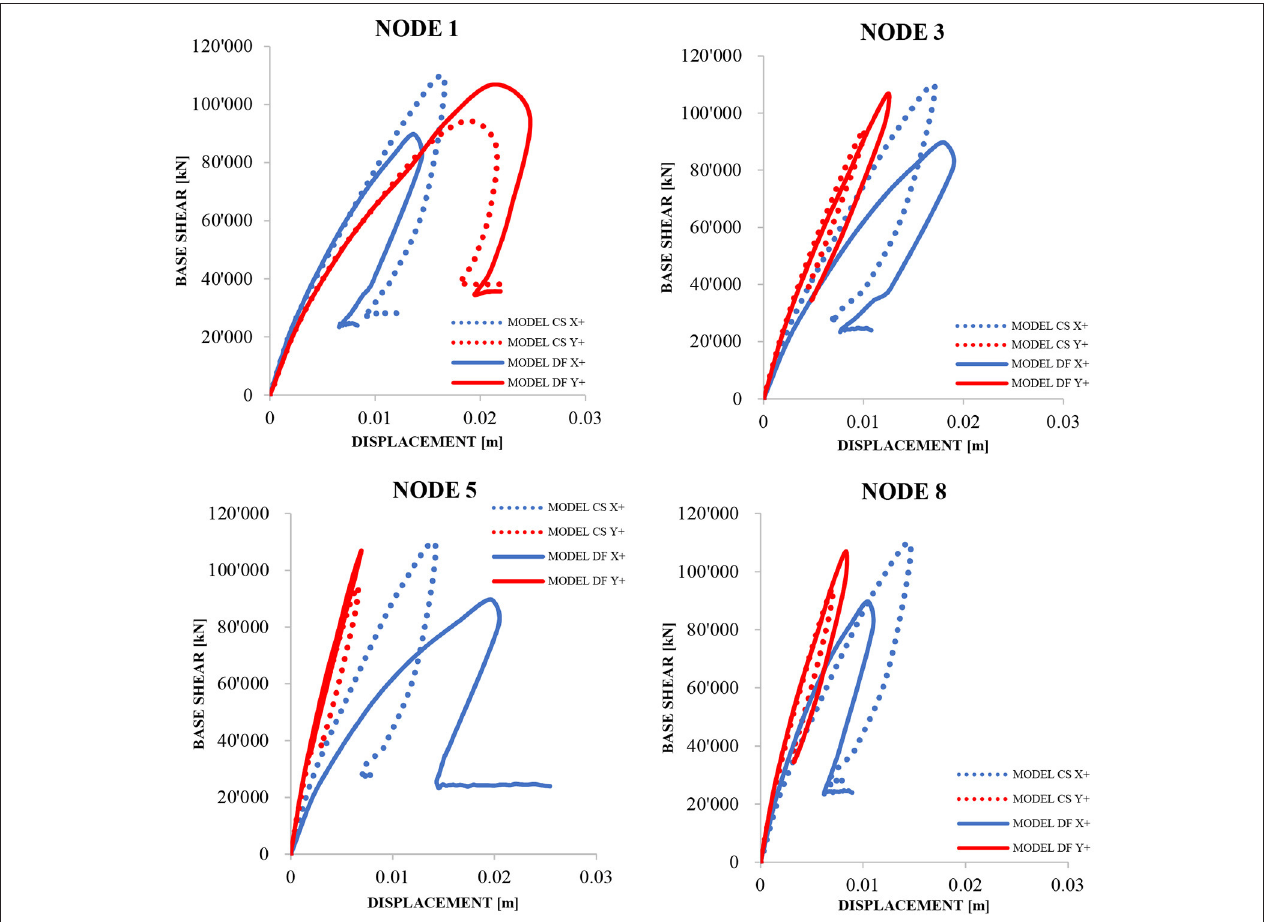
FIGURE 10 | Capacity curves at varying of control points for Model CS and Model DF in X and